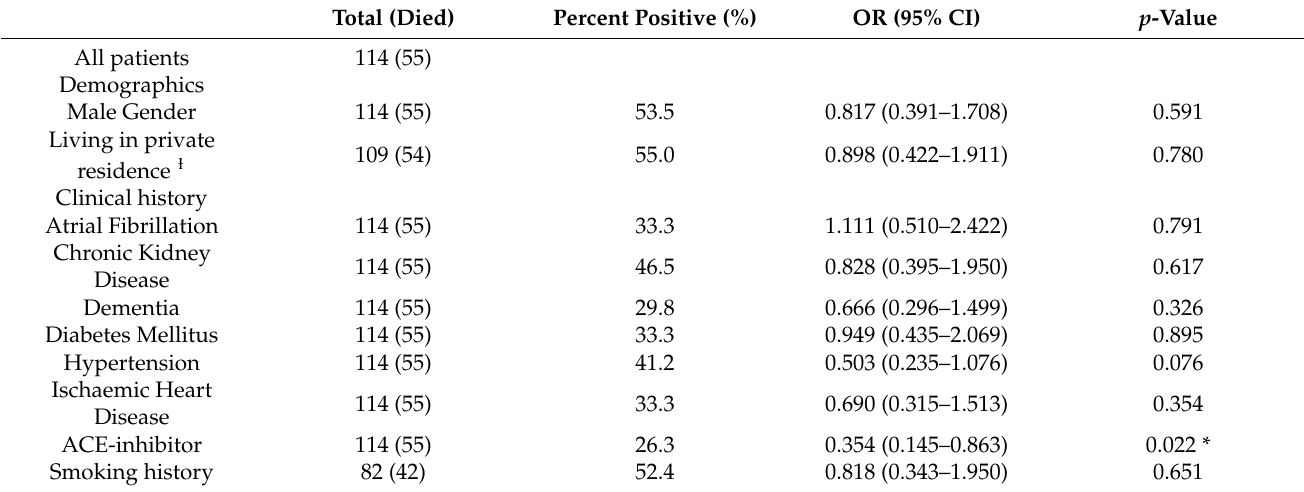
Table 1. Results of univariate logistical regression of categorical variables against inpatient death. OR, Odds ratio; CI, Confidence interval. Ɨ , As opposed to care home residence or supported living. *, p < 0.05; ***, p <